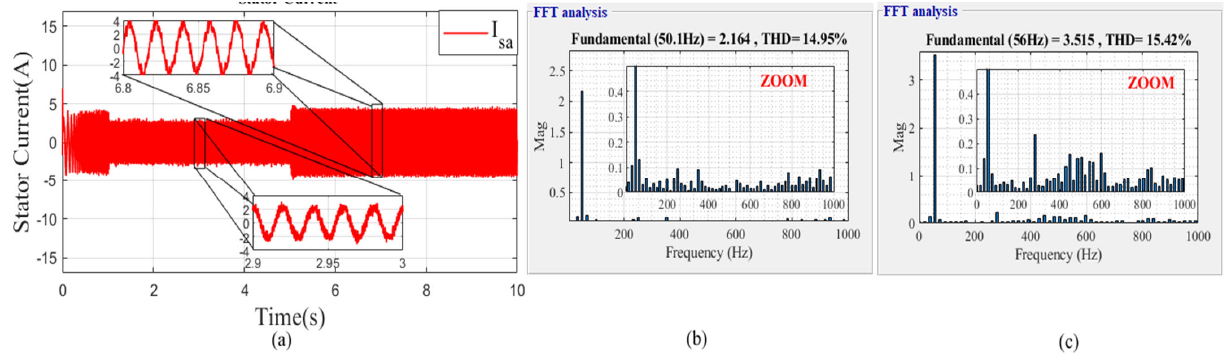
Figure 35. Performance with Cage bearing defect of IM with DTC control: ( a ) Stator current and ( b ) THD at no ‐ load and ( c ) THD with load (5 Nm).